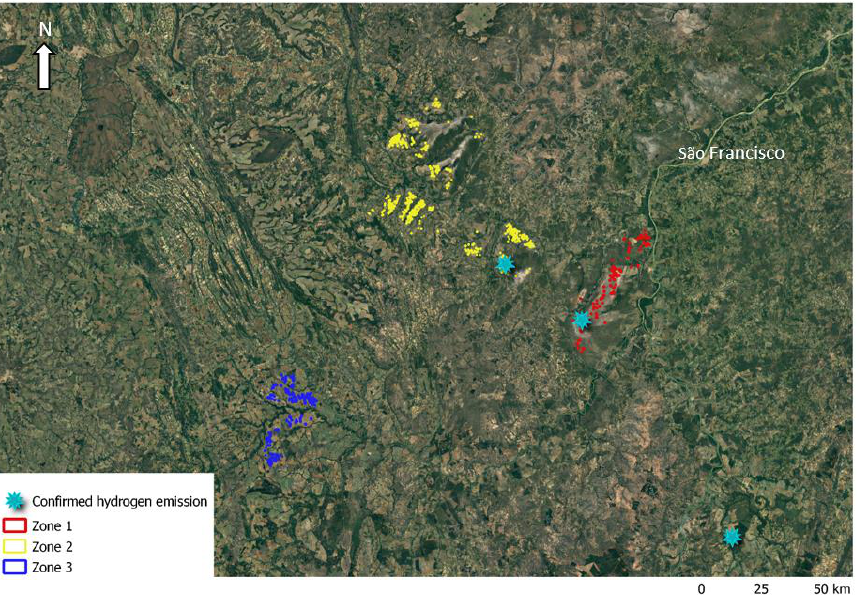
Figure 2. São Francisco Basin, Brazil. The area where H 2 emissions have been already measured are presented with turquoise stars. Each corresponds to a set of measurements (from 10 to 100). The location on the fairy circles mapped in the present work are: in red the area called Brazil_1 here. It is where the monitoring is taking place for 2 years [23,24,27], in yellow: Brazil_2, in dark blue: Brazil_3.